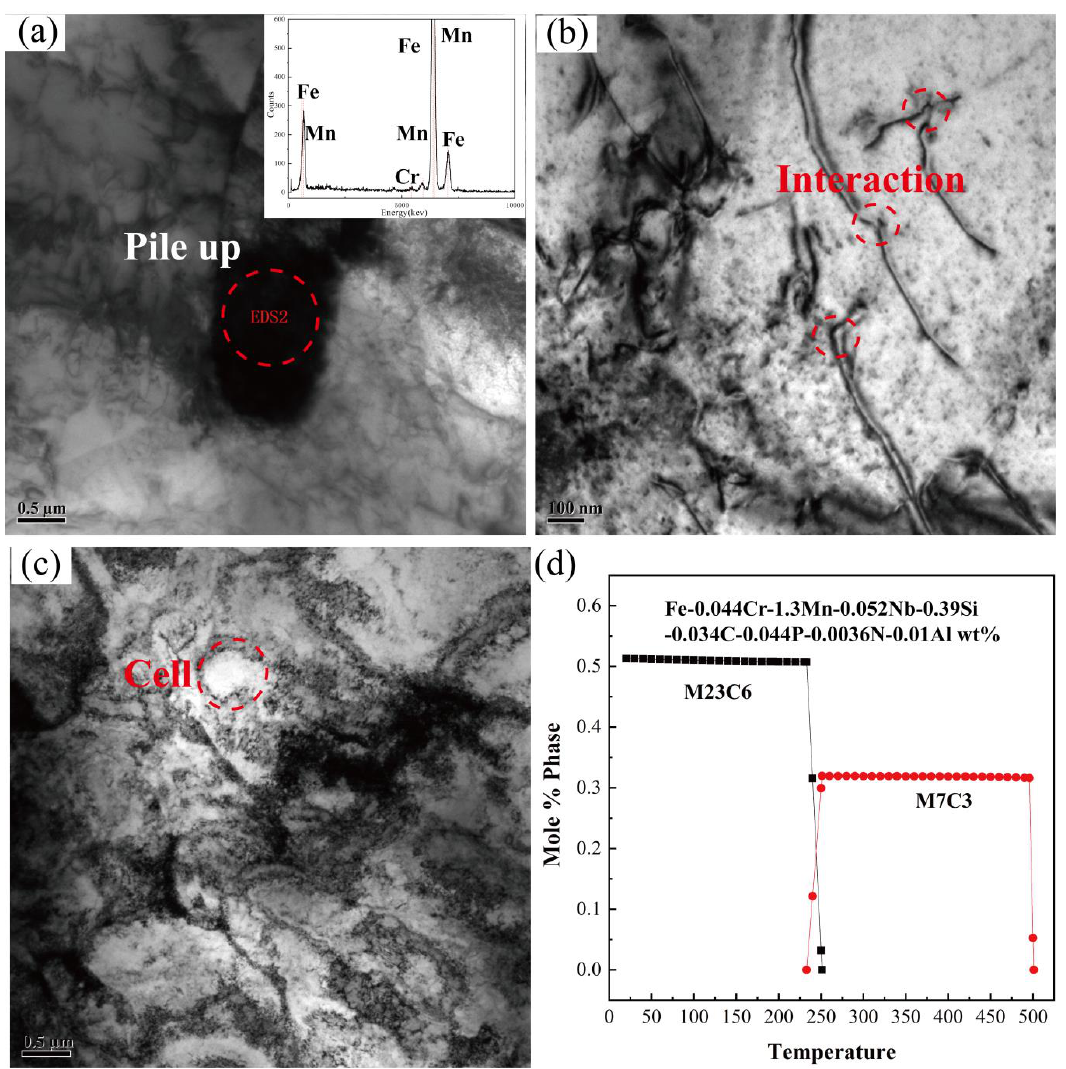
Figure 10. Dislocation density and morphology: ( a ) 350 ◦ C and EDS (Energy Dispersive Spectrometer); ( b ) 450 ◦ C: interaction (dislocation and precipitated); ( c ) 550 ◦ C: cell structure; and ( d ) precipitate re-dissolution calculations.